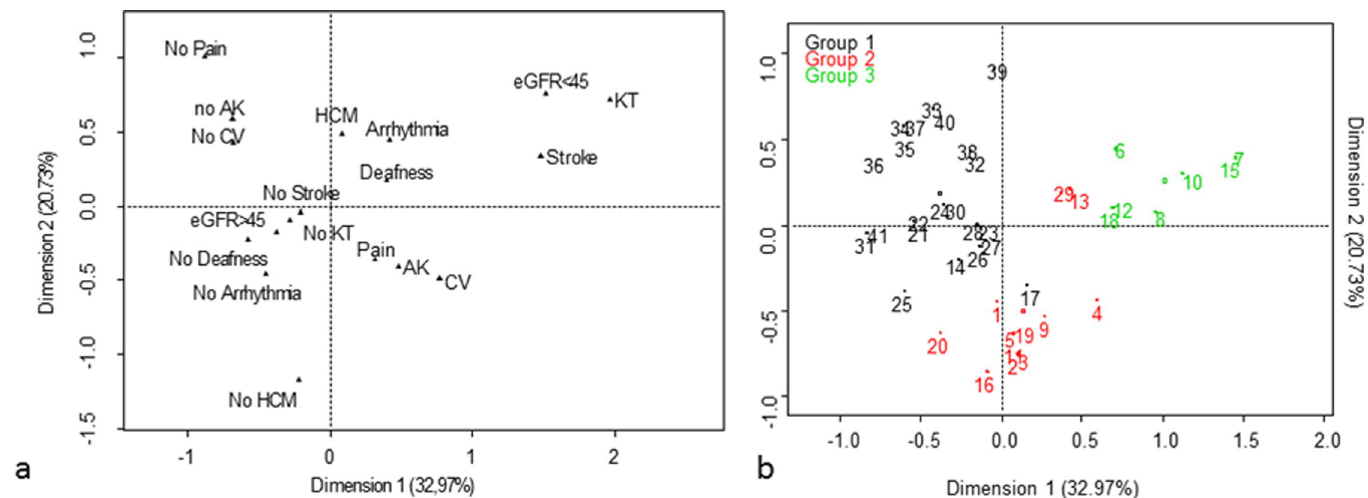
Fig 1. a: Variable factor map obtained by multiple component analysis using data for 41 males with complete data (AK: angiokeratoma; CV: cornea verticillata; eGFR: estimated glomerular filtration rate in ml/min/1.73 m 2 ; HCM: hypertrophic cardiomyopathy; KT kidney transplantation). b: Ascending hierarchical classification of individuals using the first 5 dimensions of multiple component analysis performed using data for 41 males with complete data. Three clusters were identified. Group 1, characterized by the absence of cornea verticillata (p < 10 − 7 ), the absence of angiokeratoma (p < 10 − 4 ), the absence of acral pain (p < 0.001) and the absence of renal disease, was referred to as the nonclassical cluster. Groups 2 and 3, characterized by the presence of cornea verticillata (p < 0.002), were referred to as classical groups with younger (mean age 32.3 +/- 9.9 years) and older (mean age 48.8 +/- 9.5 years) patients, respectively.